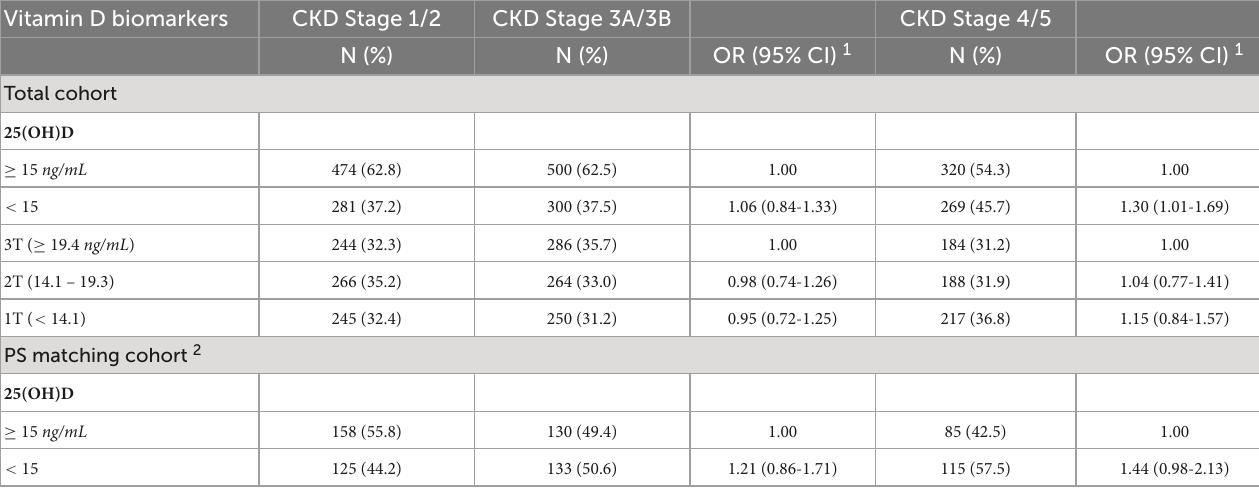
TABLE 1 Association between serum vitamin D levels and moderate (Stage 3A/3B) and severe CKD (Stage 4/5) stage in the Korean Cohort Study for Outcome in Patients With Chronic Kidney Disease (KNOW-CKD) study, 2011-2015. Vitamin D